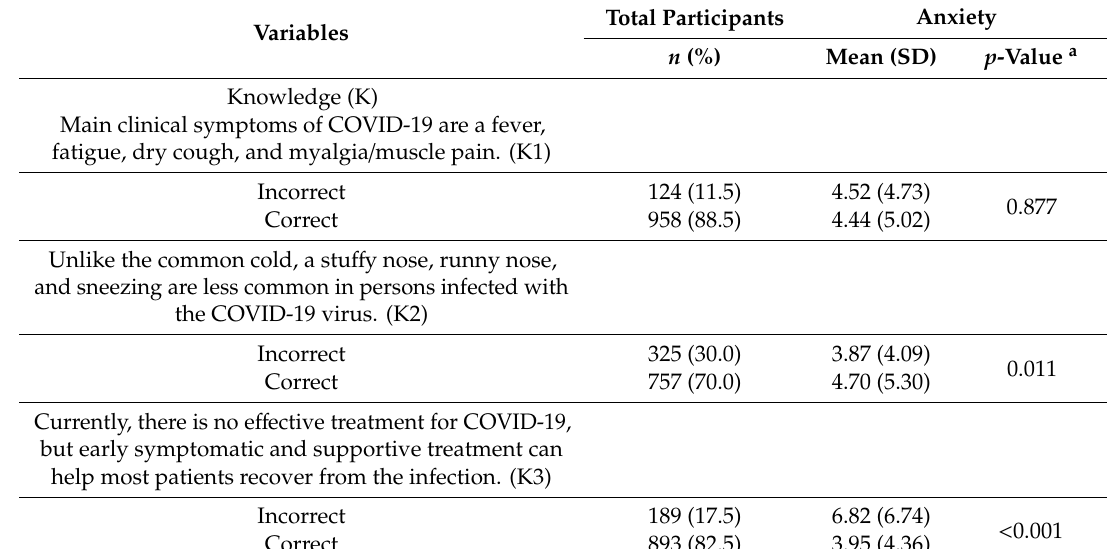
Table 2. Comparisons of participant’s knowledge, attitudes, practices, and spirituality with their anxiety scores towards the COVID-19 pandemic among an Indonesian population ( n =